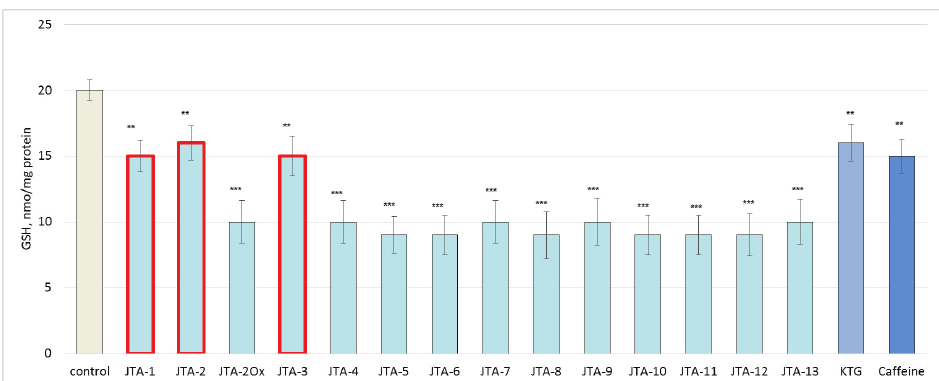
FIGURE 5 - Effects of caffeine-8-thioglycolic acid (KTG) derivatives, administered alone, on level of GSH after 1 h of treatment. Mean ± SEM (n = 6). ** P < 0.01; *** P < 0.001 – vs control (non-treated synaptosomes).